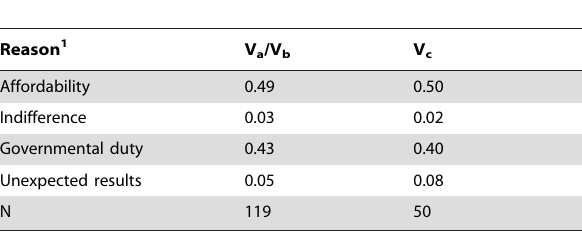
Table 4. Regression of Ratio 1 and Ratio 2 . Table 5. Reasons for negative response for